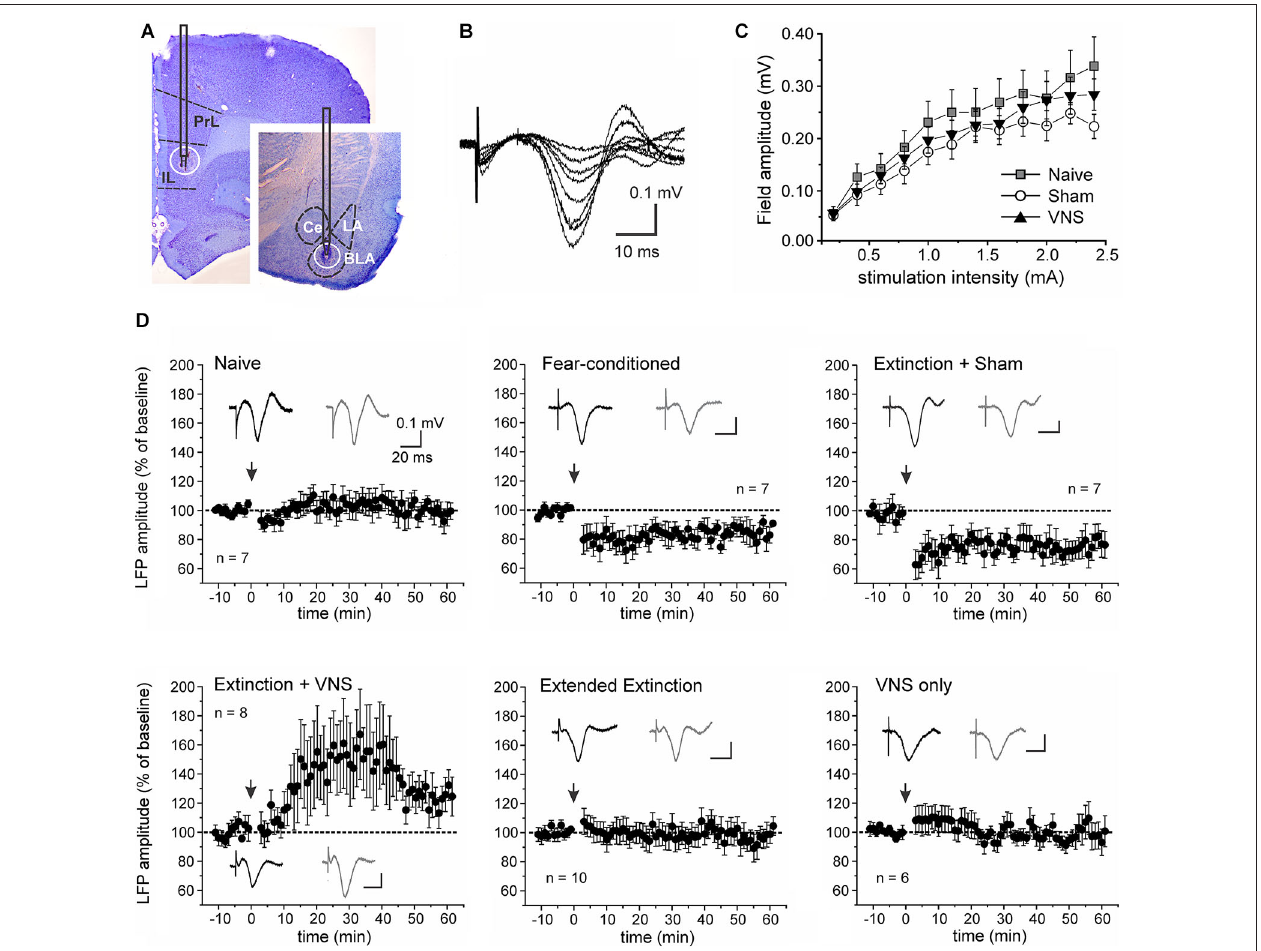
sham-stimulation during a single extinction session (4 tone presentations), burst stimulation induces LTD. Bottom row: In rats that received extended extinction training (20 tone presentations) and showed reduced freezing behavior, LTD induction is abolished. In